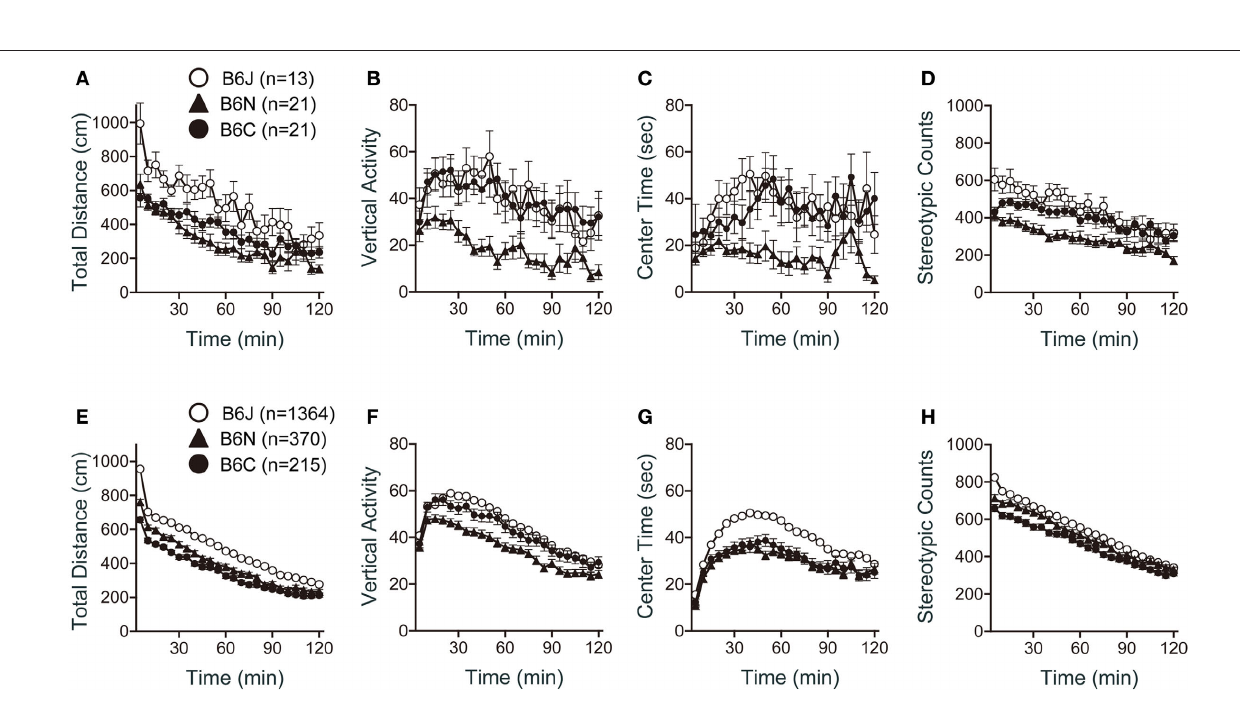
Figure 3 | Open field test of C57BL/6 substrains. (A–D) Regular scale analysis. (e–H) Large-scale analysis. (A,e) Total locomotion distance traveled. C57BL/6J mice traveled the longest distance. (B,F) Count of vertical activity. C57BL/6N exhibited the lowest vertical activity. (C,g) Time spent in the center of the compartment. (D,H) Count of stereotypic behavior. Error bars indicate SEM.